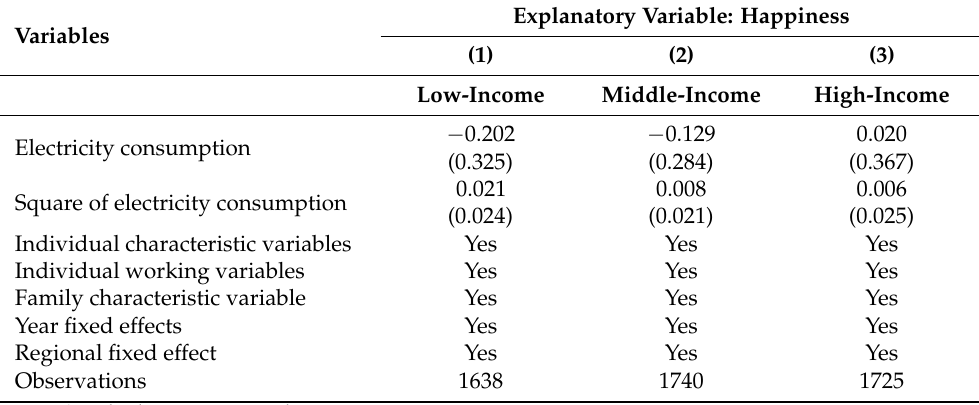
Table 11. Further analysis: tests of nonlinear effects among various annual household income